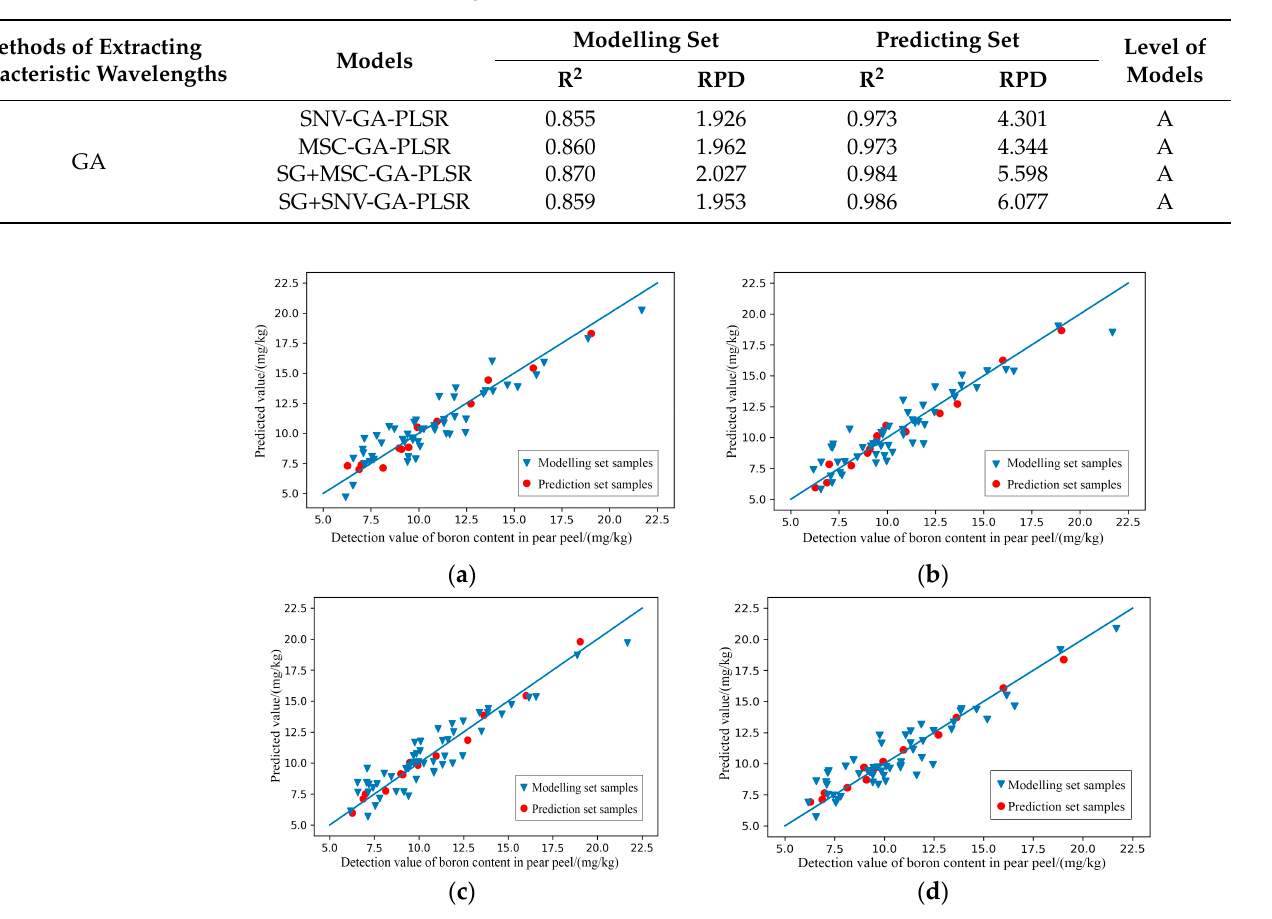
Figure 15. Scatter plots of models’ prediction results of the content of boron in pear peel samples.